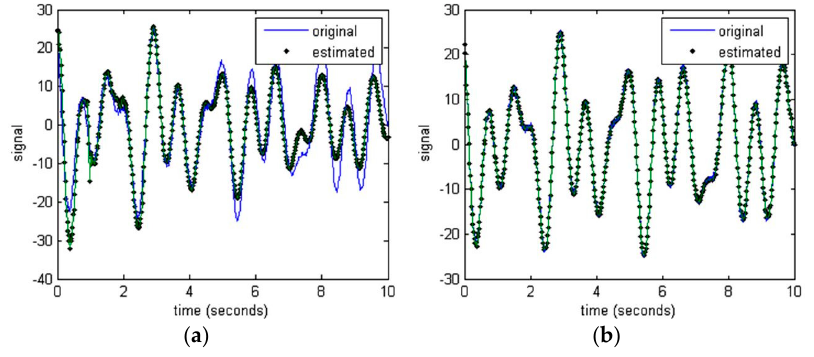
Figure 8. Comparison of the original and estimation signal (sampling 1/60 s, α = − 0.01). ( a ) ExPRO; and ( b ) MuPRO.